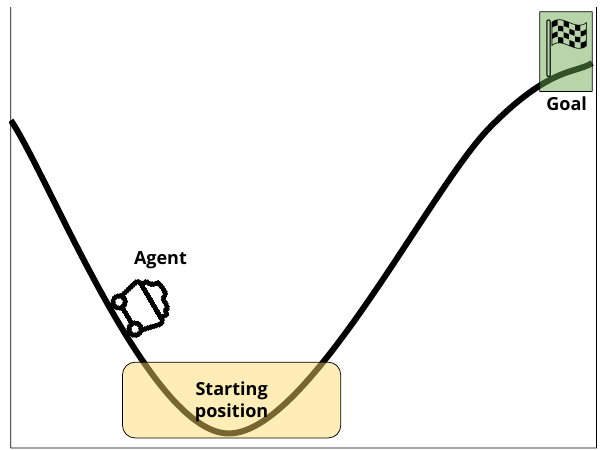
Figure 3. The Mountain Car scenario used in this work. The agent begins at a random position within the starting region shown in yellow and must reach the goal position shown in green. The agent does not have enough power to drive directly to the goal position, therefore, it needs to build up momentum by going back and forth between the